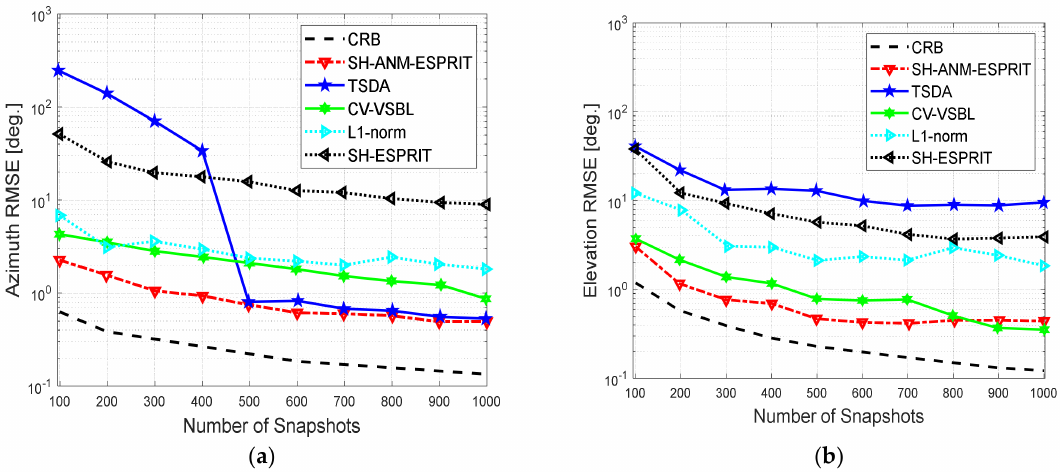
Figure 4. Comparison of performance with different value of snapshots under uncorrelated sources at ( θ , ϕ ) = ( 30 ◦ ,60 ◦ ) and ( 36 ◦ ,138 ◦ ) , 0 dB SNR. ( a ) Azimuth. ( b ) Elevation.